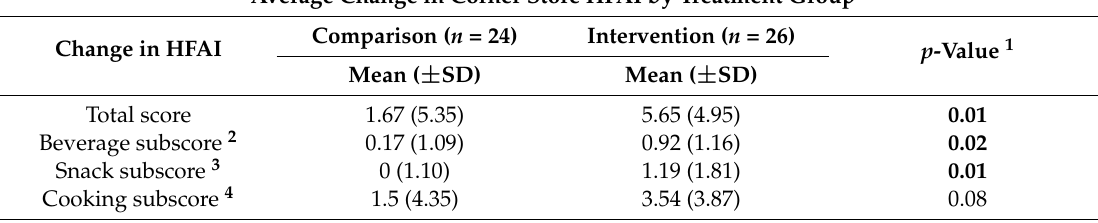
Table 3. Average change in corner store healthy food availability index